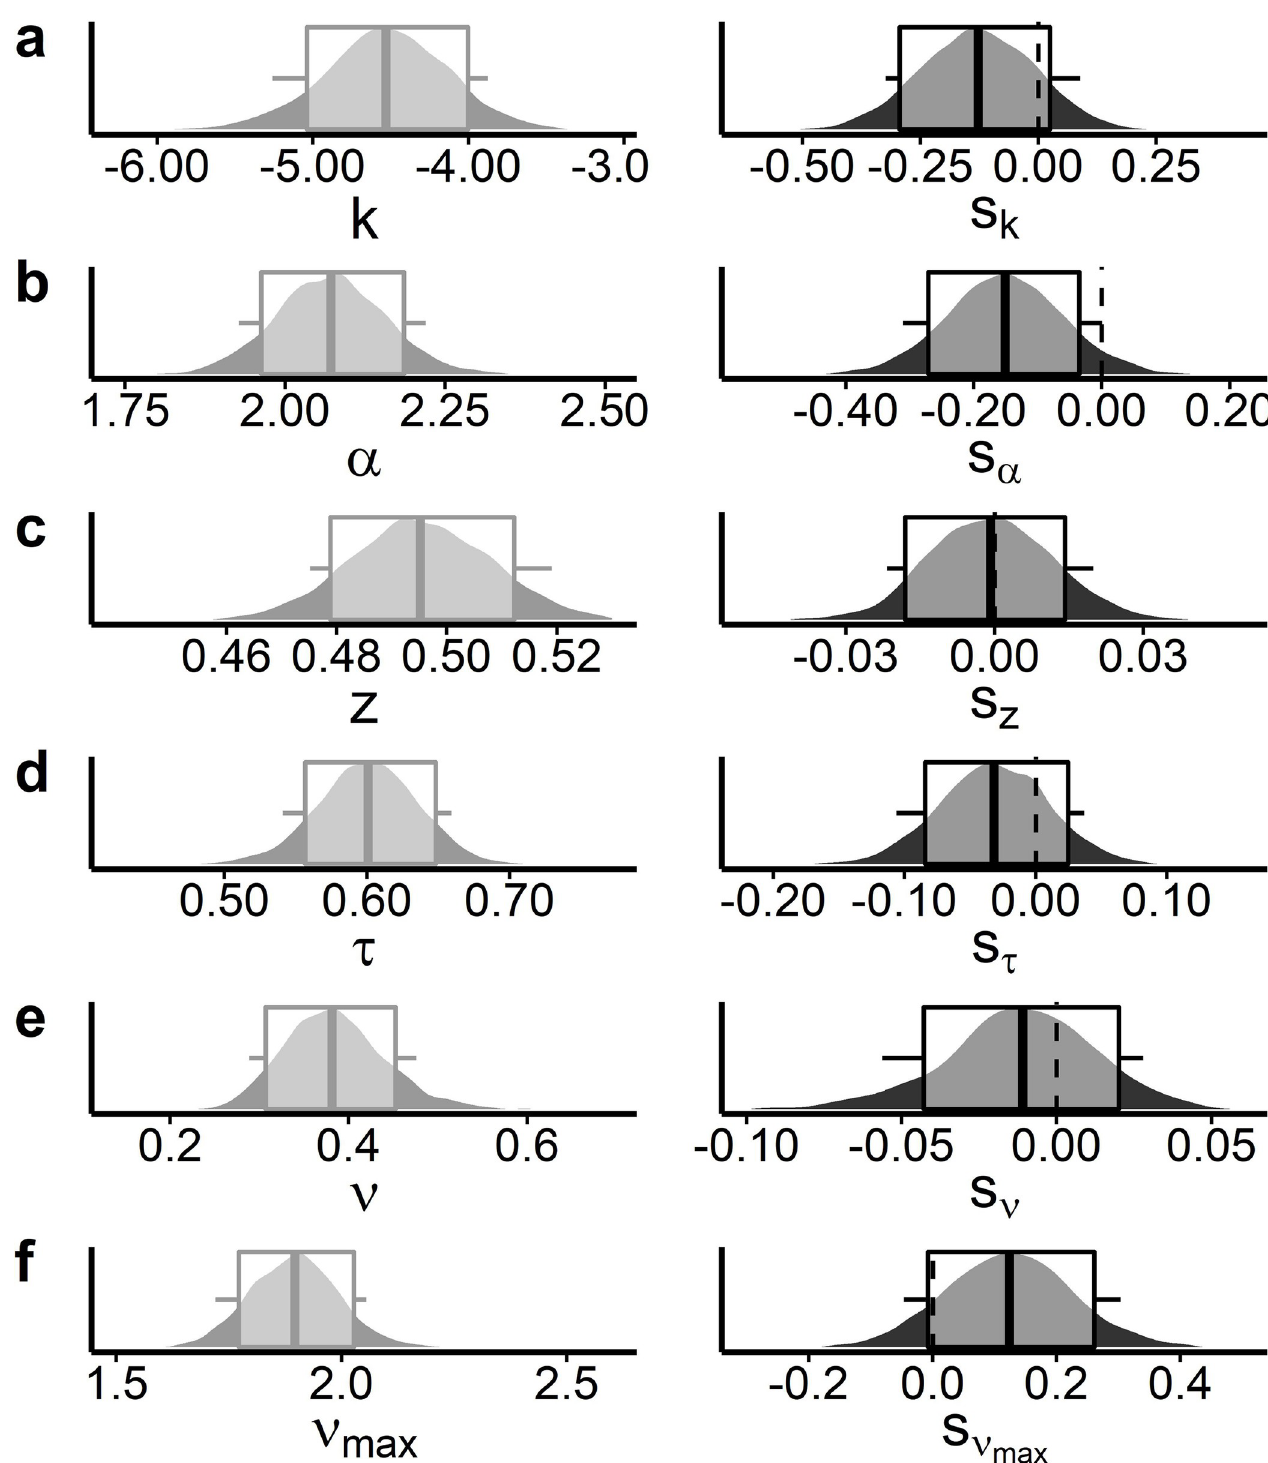
Fig 7. Posterior parameter distributions of the DDM s group-level means of the temporal discounting data following placebo intake (left column, light grey plots) and their respective shifts related to tyrosine intake (right column, dark grey plots). Boxplots depict 80% and 90% HDIs. Depicted parameters are (A) discount rate log( k ), (B) decision-threshold α , (C) starting point bias z , (D) non-decision time τ , (E)(E) drift-rate v and (F) drift-rate asymptote v their tyrosine-related ‚shifts‘. Only decision-threshold α showed strong evidence for a shift following tyrosine intake according to directional BF and 90% HDI (dBF < .1 and HDI < 0; see Table